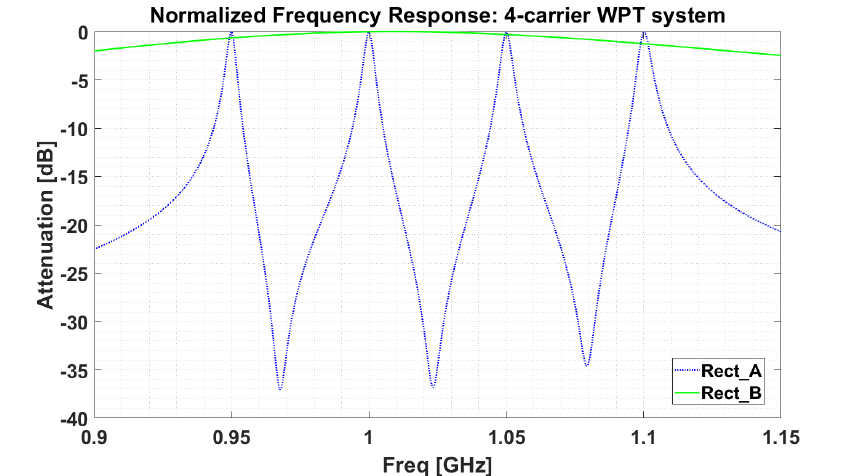
Figure 4. Frequency response of the proposed WPT rectifier ( Rect _ A ) and of the wide-band rectifier ( Rect _ B